Question: How would you classify this visualization?
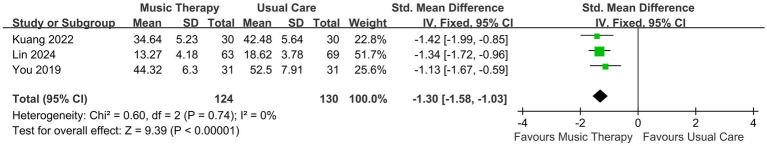
Answer: forest